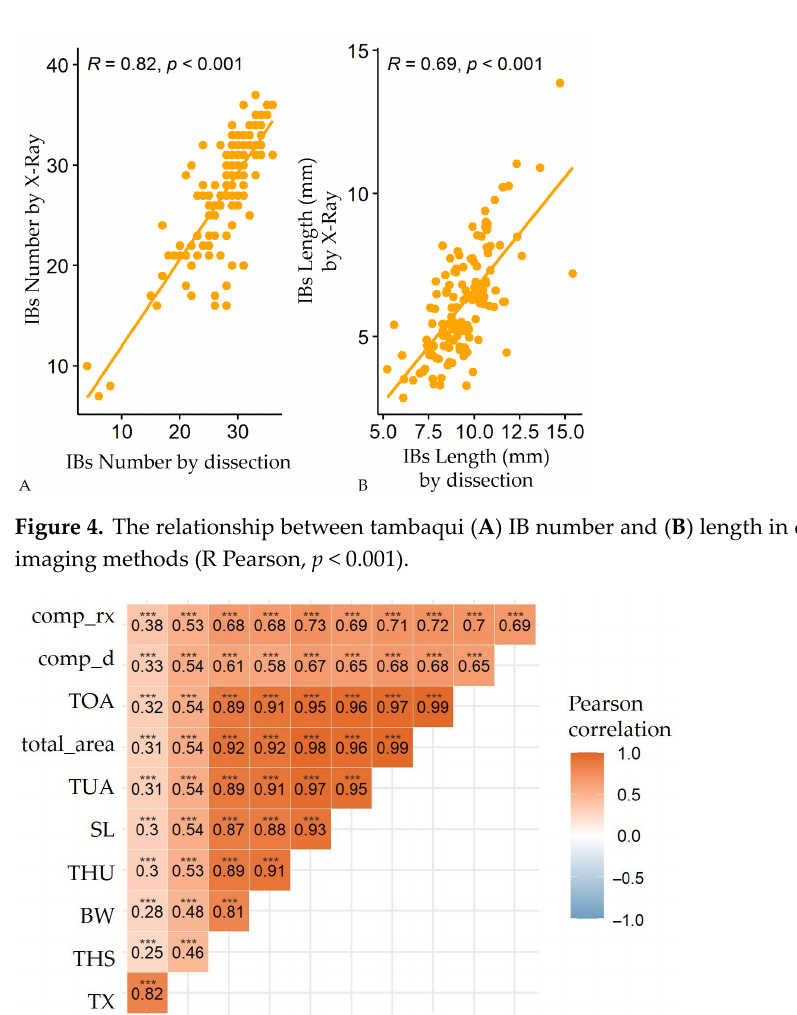
Figure 3. Frequency distribution of the deviation values in IBs numbers between X-ray imaging and dissection methods in tambaqui.